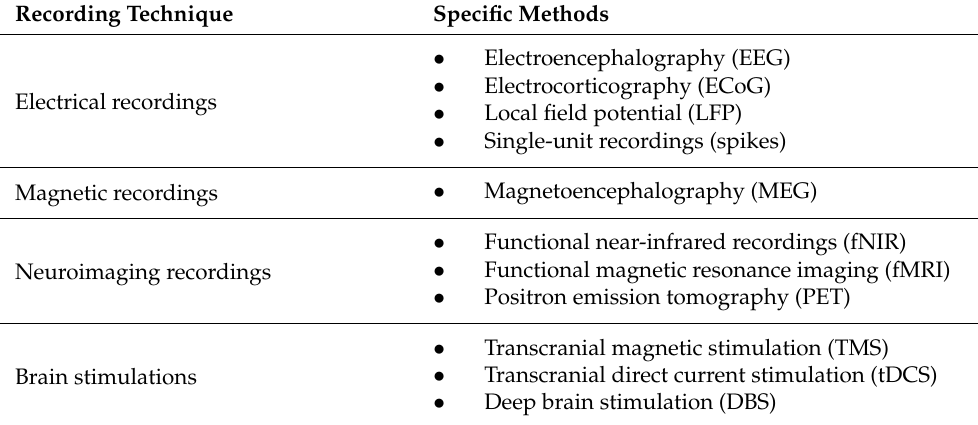
Table 1. Neuronal recording